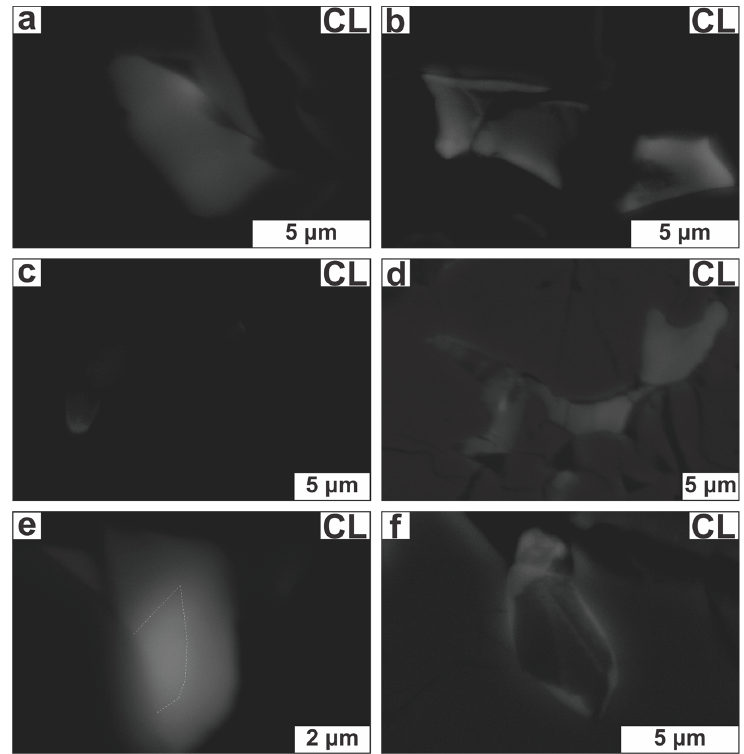
Figure 8. Cathodoluminescence (CL) images of selected Zr-bearing silicate crystals. ( a ) Zircon (marked by the red, open square in Figure 6c) with nearly homogeneous texture; ( b – e ) Zirconium-bearing silicates with irregular texture [originally depicted in Figures 6f and 7a–c (in the last figure the imaged zircon is marked by a red square)]; ( f ) Armstrongite (originally depicted in Figure 7e) with very weak CL intensity.